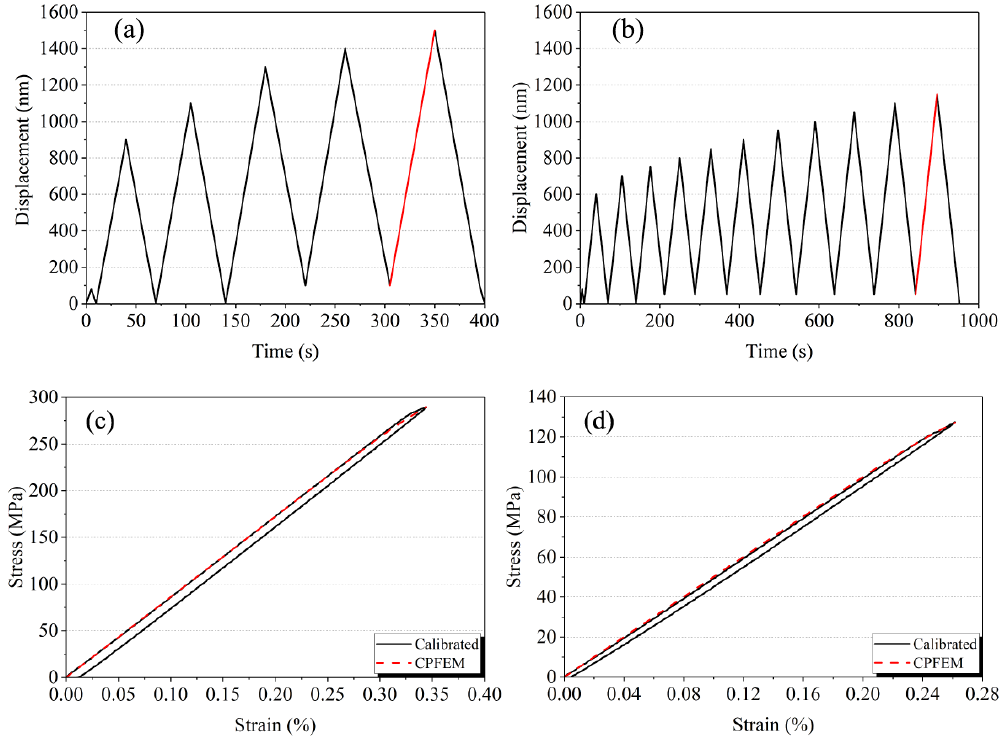
Figure 2. Loading curves obtained with displacement control mode for the compression tests of ( a ) Ni and ( b ) α -Brass. Only red lines contribute to plastic deformation, and all the previous cycles are in the elastic state. Stress–strain curves were corrected by CPFEM simulations for ( c ) the Ni micro-pillar and ( d ) the α -Brass micro-pillar. The applied stress at the end of the compression test is about 289.4 MPa for the Ni sample and 127.4 MPa for the α -Brass